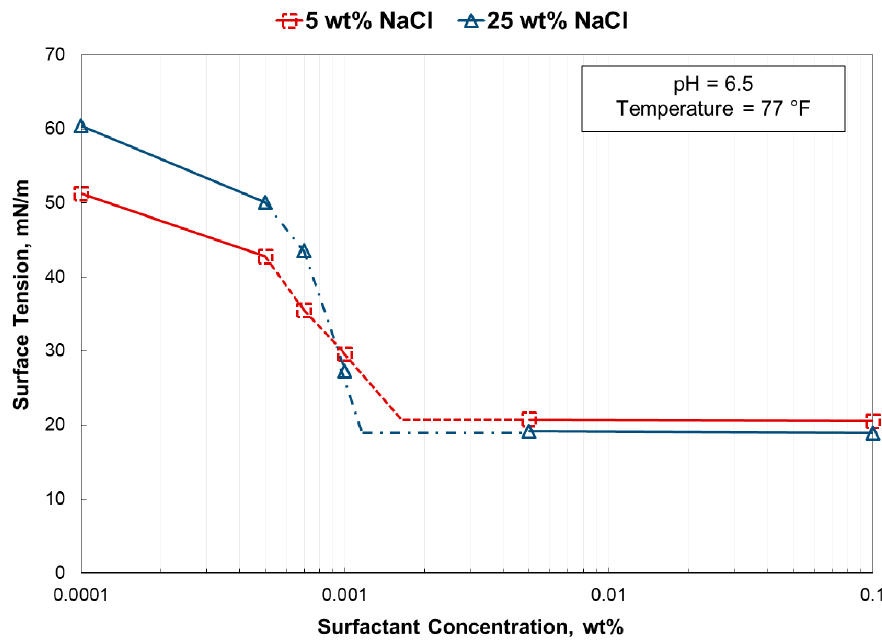
Figure 15. Role of NaCl concentration on the surface tension, CMC, and surface tension gradients at pH 6.5 and 77 °F (25 °C).